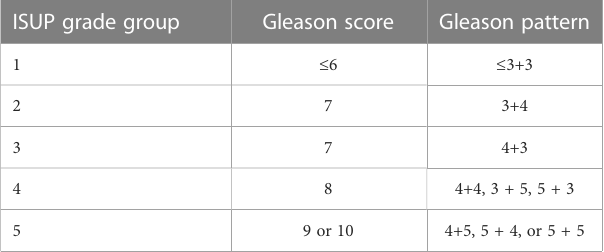
Table 3. No specimen was classi fi ed as ISUP 1. Most index lesions were located in the PZ of the prostate. Patients with different ISUP grades were relatively evenly distributed over the eight scanners, details are available in Supplementary Table 1.